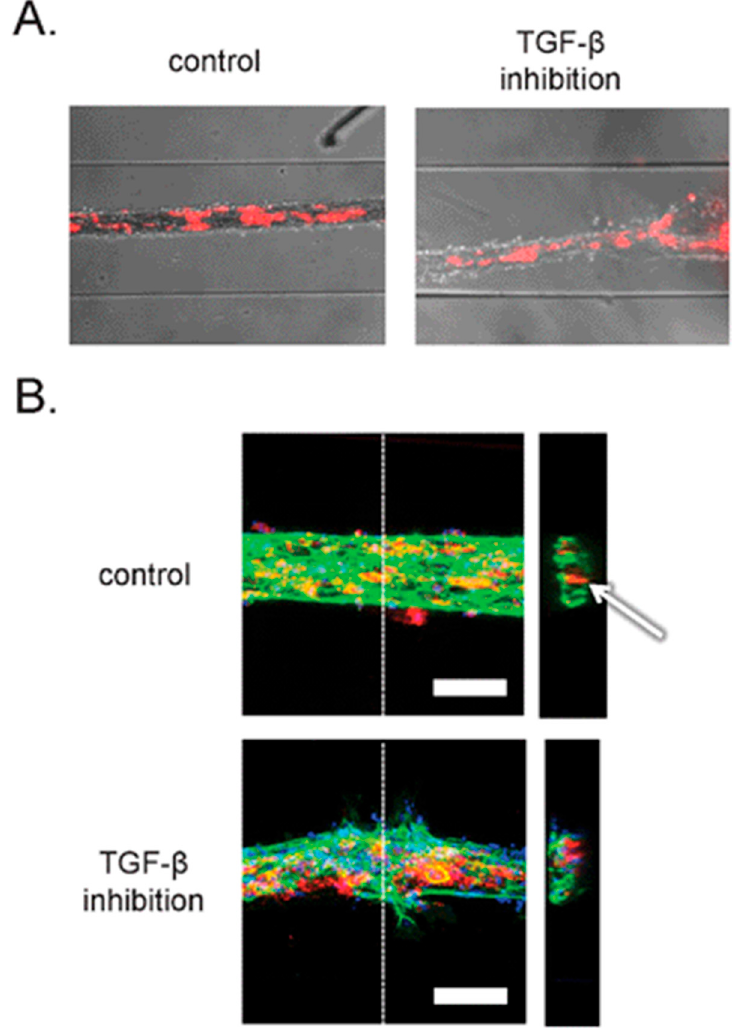
Figure 6. ( A ) Brightfield images combined with epifluorescence images of an OOC platform. ( B ) Confocal microscopy images taken from the same OOC platform to obtain a higher level of detail of the 3D structures and interactions within this OOC device. Reproduced from [32] with permission, © 2013 Royal Society of Chemistry.